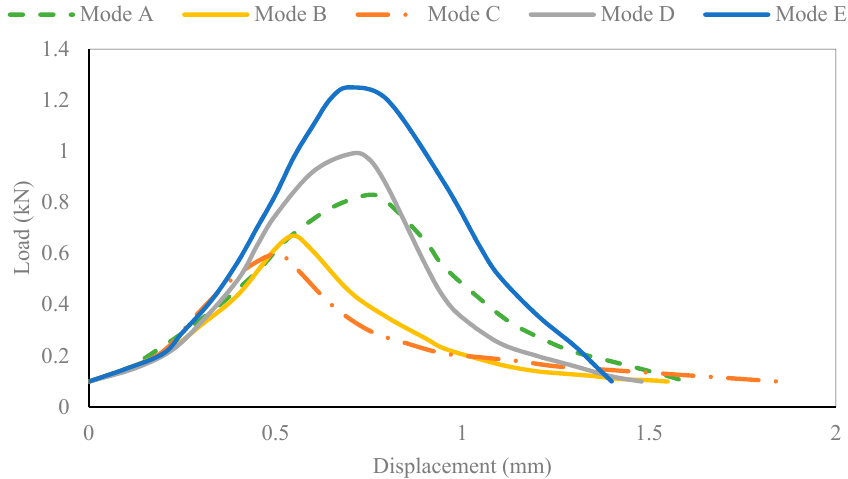
Figure 4. Load–displacement curves of CR-20 mixture in different mixed-mode levels.